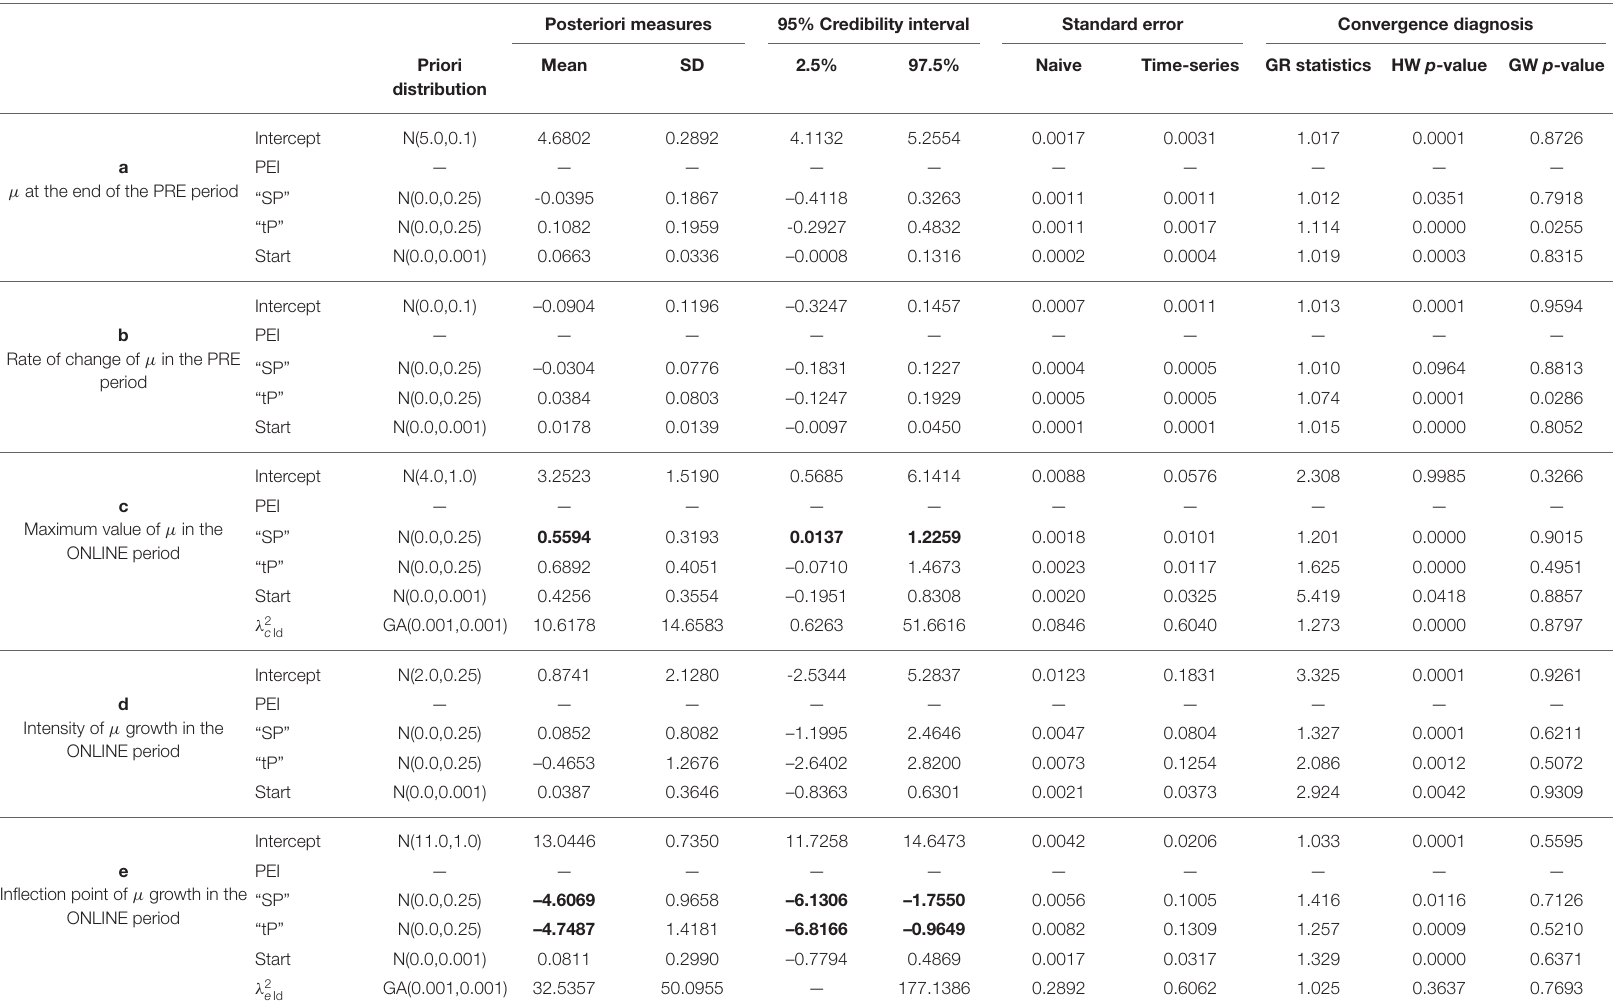
TABLE 2 | Summary measures for the model